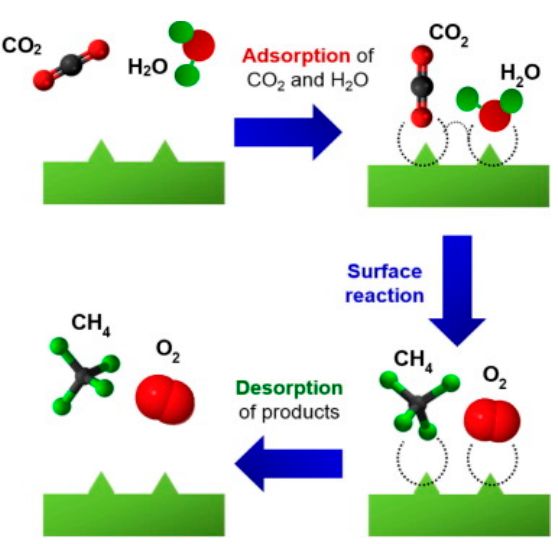
Figure 3. Basic illustration describing the reaction mechanism of CO 2 photoreduction. Reproduced from work in [47] . Copyright 2016 Elsevier B.V .